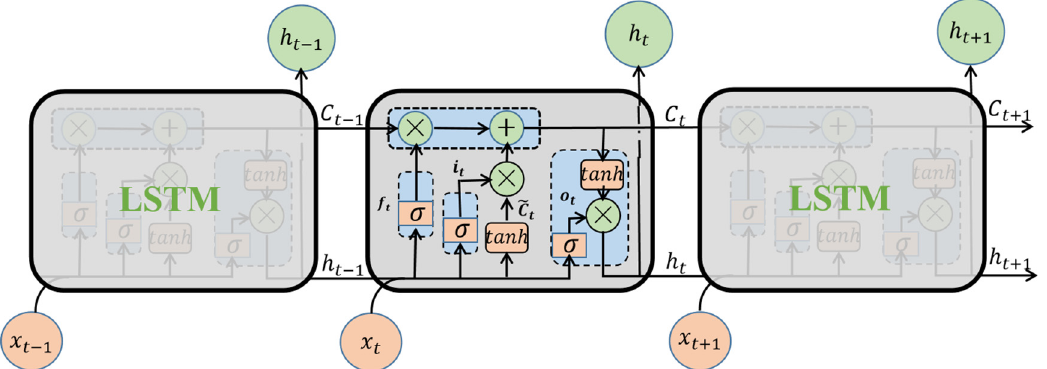
Figure 3. LSTM schematic.